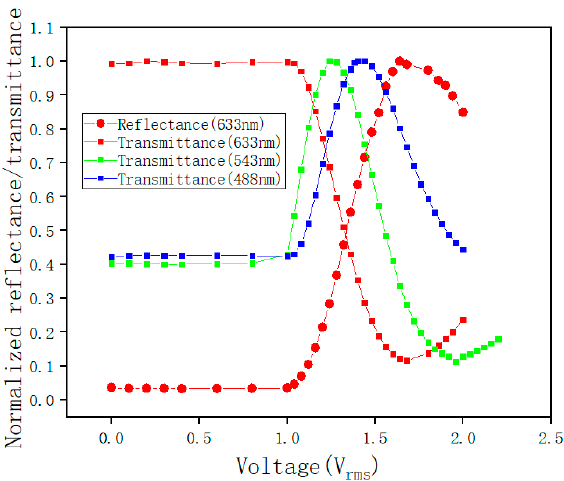
Figure 7. Voltage-dependent reflectance (632 nm laser) and transmittance (633 nm, 543 nm, and 488 nm lasers) of the system.